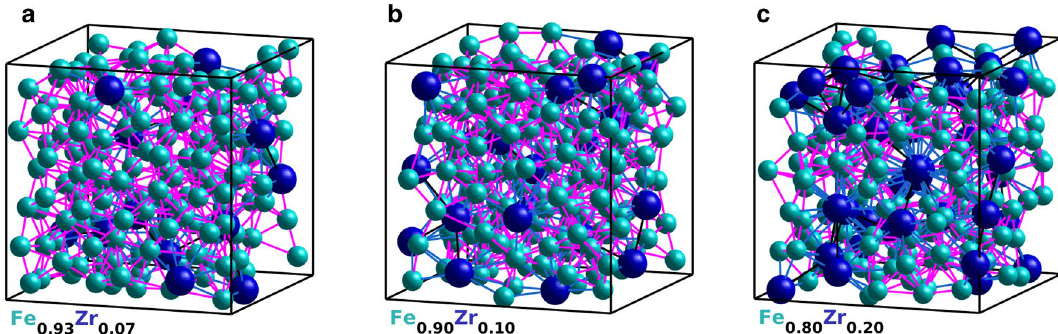
Figure 1. Illustration of the atomic arrangement in one of the simulated supercells for Fe 0.93 Zr 0.07 , Fe 0.90 Zr 0.10 , and Fe 0.80 Zr 0.20 from left to right. The larger dark blue spheres represent Zr atoms and the smaller cyan spheres represent Fe atoms. Nearest neighbour bounds are indicated by lines (magenta for Fe-Fe, blue for Fe-Zr, and black for Zr-Zr). The simulations used periodic boundary